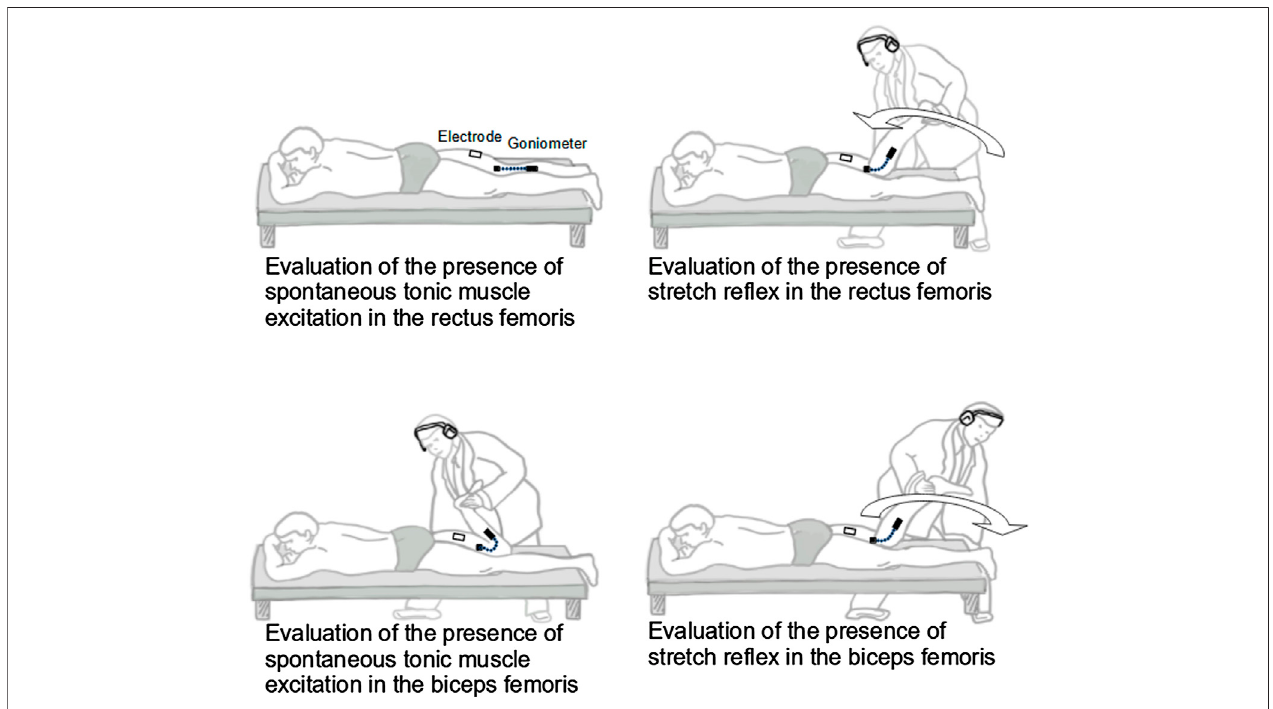
FIGURE 1 | Experimental set-up and